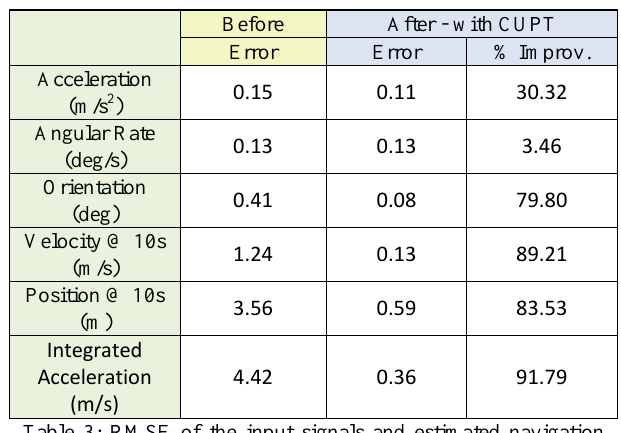
Figure 10: (Top) the reference orientation of the walking trial (with the IMU close to the wrist) determined by iMAR; (Middle) orientation errors from integrating the gyroscope signal; (Bottom) accelerometer errors from integrating the accelerometer signal in a rotating frame before and after in-situ self-calibration with CUPT.